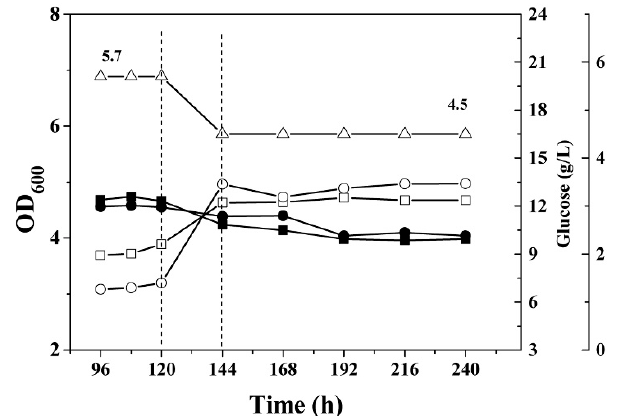
Figure 4. Growth curves and residual glucose concentration in phosphate ‐ limited continuous cul ‐ ture of the C. acetobutylicum wild type and the mutant glcCE ::int(193). ( △ ), pH; ( ■ ), OD 600 of wild type; ( ● ) OD 600 of glcCE ::int(193); ( □ ), residual glucose during cultivation of wild type; and ( ○ ), re ‐ sidual glucose during cultivation of glcCE ::int(193). The dashed line indicates the initiation of dy ‐ namic pH shift from 5.7 to 4.5 in the continuous fermentation.